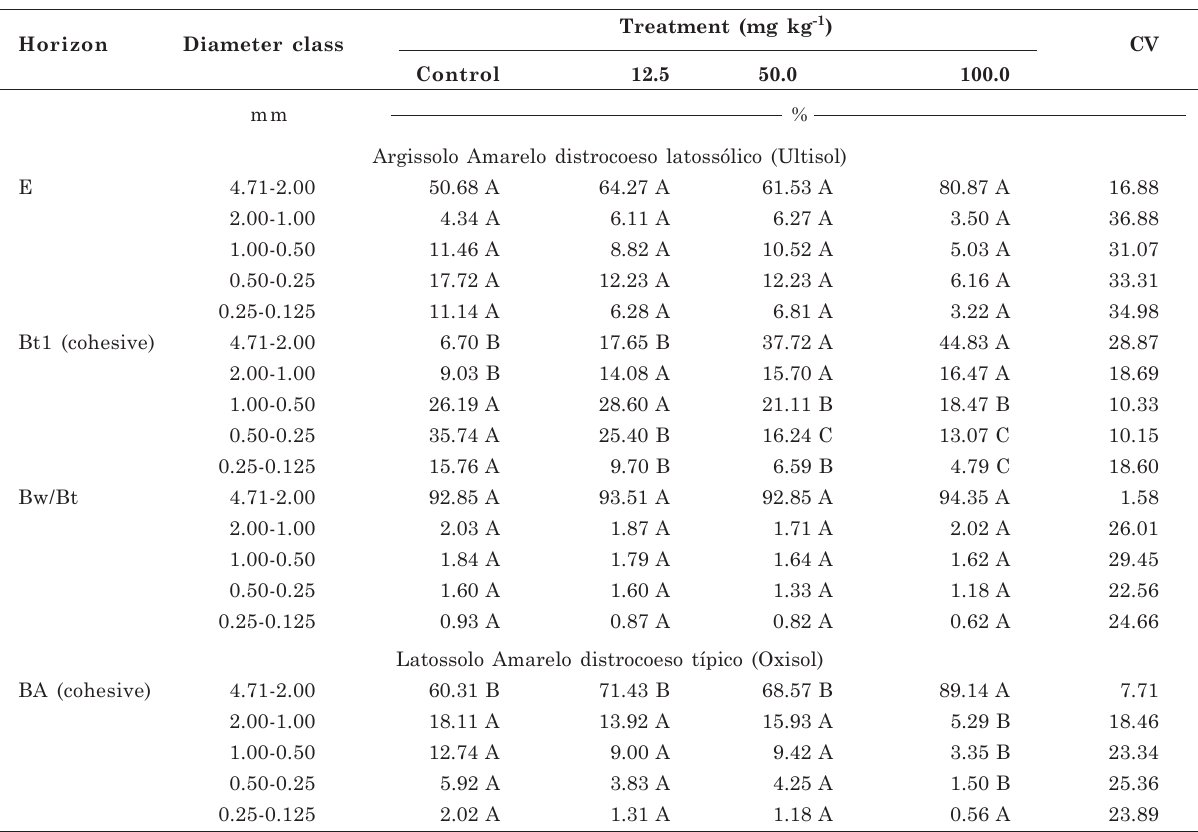
Table 3. Distribution of diameter classes of water-stable aggregates of the horizons E, Bt1, Bw/Bt (Ultisol), and BA (Oxisol) with the application of aqueous solutions of PAM (12.5, 50.0 and 100.0 mg kg -1 ) and control (distilled H 2